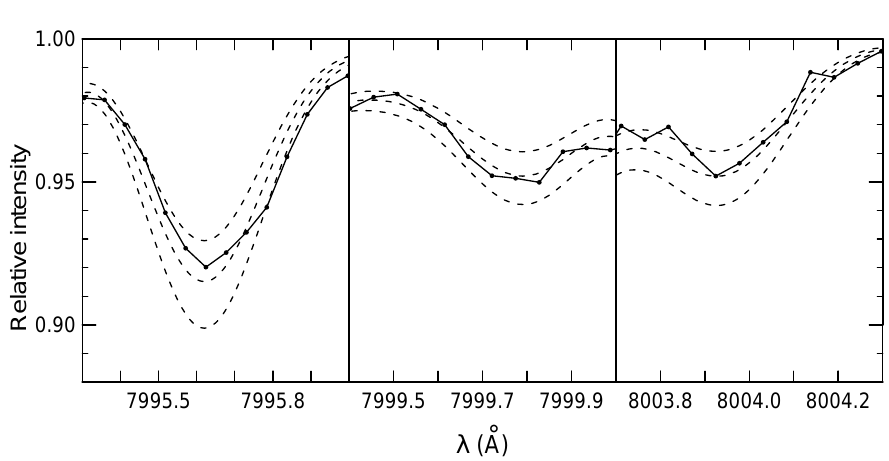
Fig. 3. Synthetic spectrum fits to the three 12 CN lines for (cid:21) And. The observed spectra are shown as solid lines joining the dots. The dashed lines denote the synthetic spectra with [N/Fe] = 0.25, 0.35 and 0.45 dex